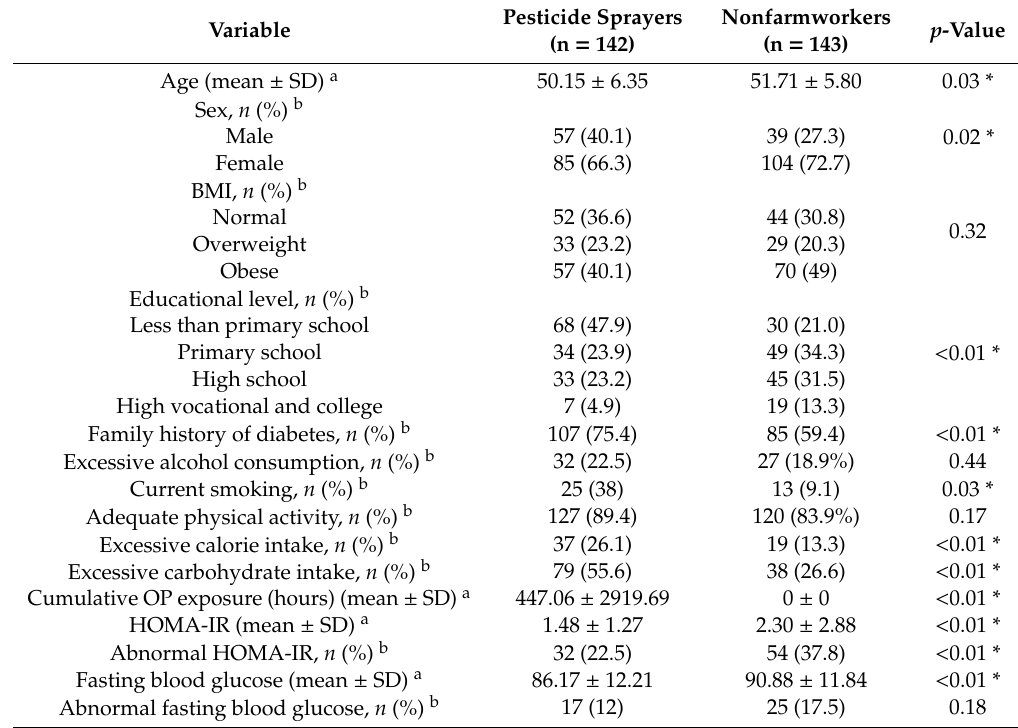
Table 1. Characteristics of participants according to occupational status.